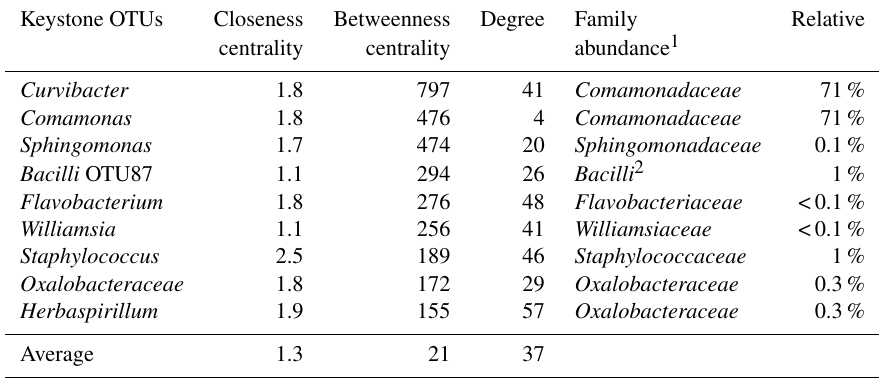
Table 5. The “keystone genera” of the active microbial communities in Outokumpu fractures.